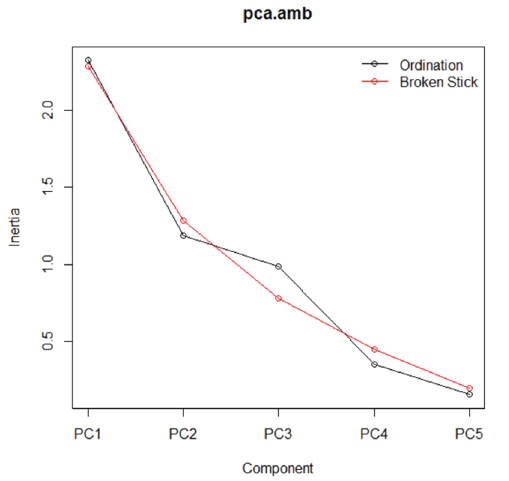
Figure 2. Result of the Principal Components Analysis (PCA) showing the scree plot for the physiochemical variables in the 15 marginal lakes along to the Paraguay River,